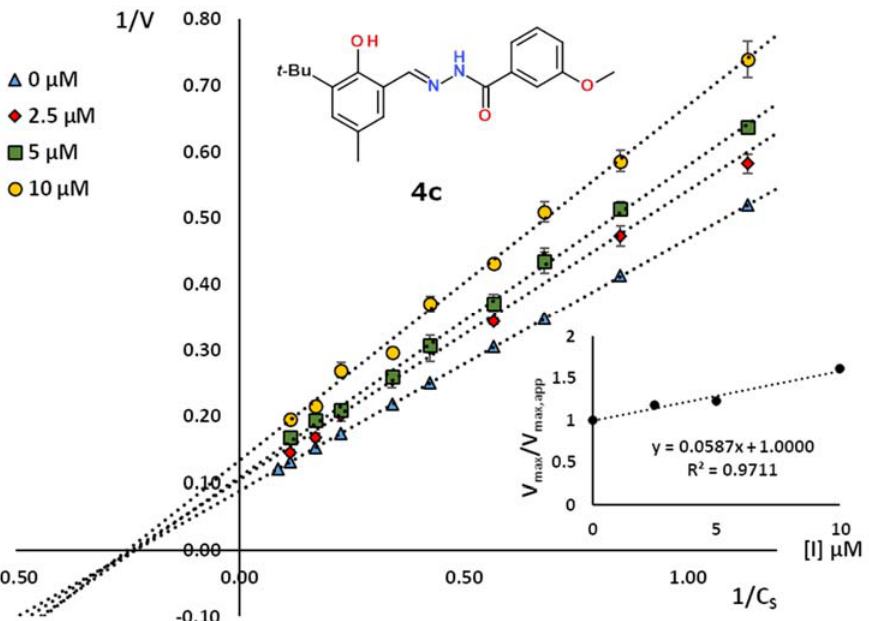
Figure 6. The Lineweaver–Burk plots (1/V [min µ M − 1 ] = f(1/C S ) [ µ M − 1 ]) for 4c the inhibitor concen- tration up to 10 µ M. The additional graphs show the linear dependence of V max /V max,app = f(I) [ µ M] for non-competitive mechanism.